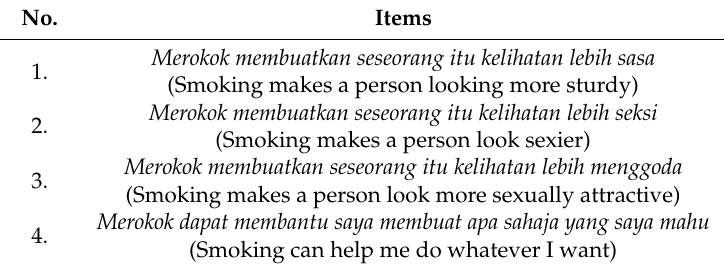
Table 2. Four eliminated items from the face and content validity phase.